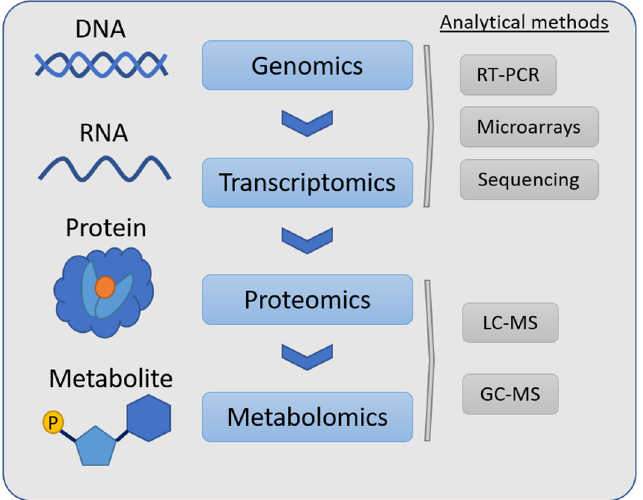
Figure 1 . Overview of different omics sciences and their analytical methods. Figure 1. Overview of different omics sciences and their analytical